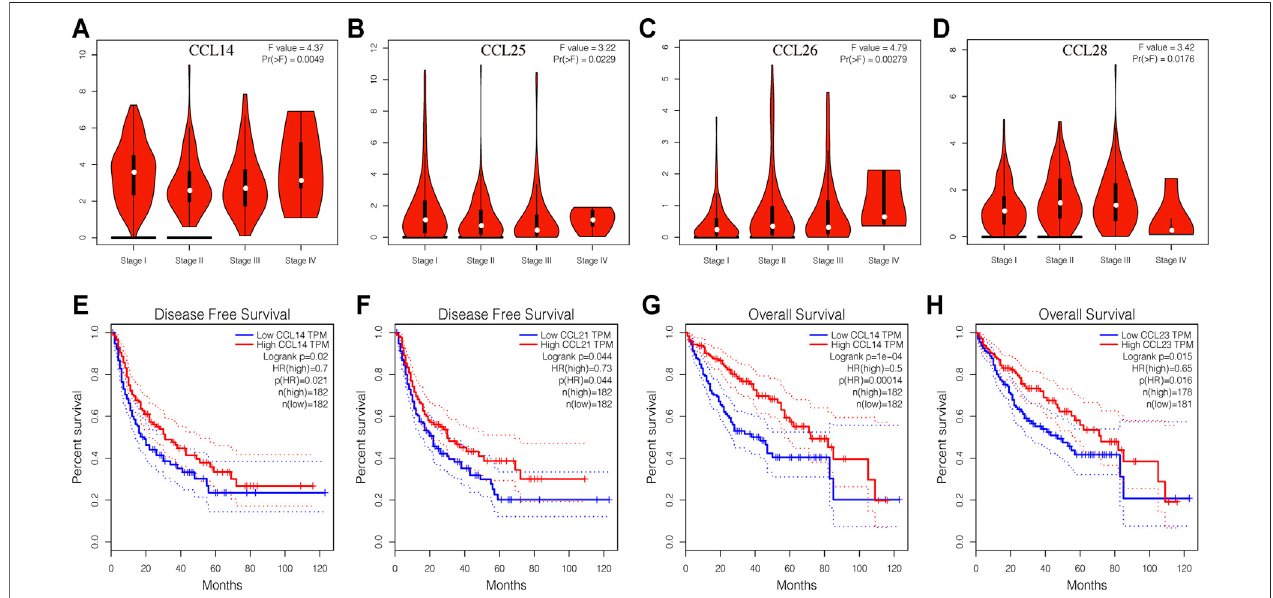
FIGURE 3 | Correlation between aberrantly expressed chemokines CCL and the pathological stage, DFS, and OS of LIHC patients (GEPIA). (A – D) Correlation between the pathological stage and expression of CCL14, CCL25, CCL26, and CCL28, respectively. (E,F) The prognostic value of expression of CCL14 and CCL21 in LIHC patients in the DFS curve. (G,H) The prognostic value of expression of CCL14 and CCL23 in LIHC patients in the OS curve. p < 0.05 was considered statistically signi fi cant.